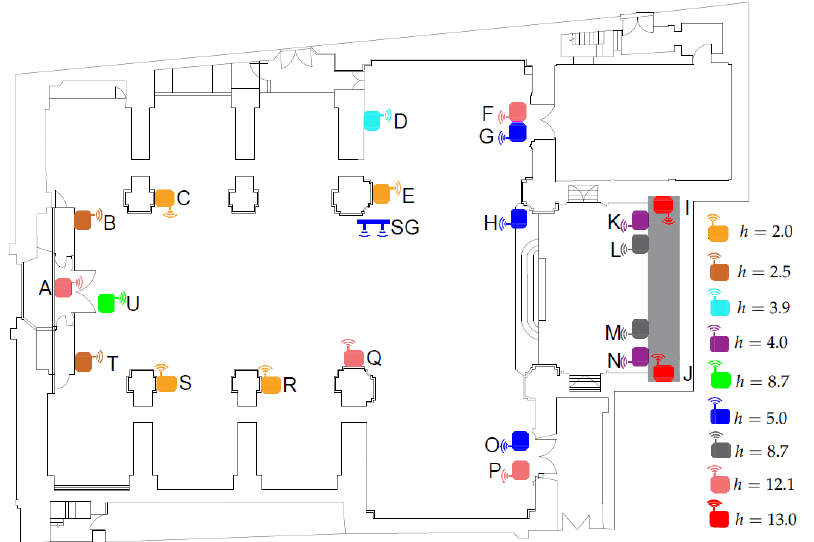
Figure 4. Position of the 21 wireless nodes located in the church of Saint Thomas and Saint Philip Neri (Valencia, Spain). Color refers to height ( h ) of the node (in meters, m). SG indicates the position of the sink gateway that receives data wirelessly from the sensor nodes. The light gray rectangle indicates the position of the main altarpiece